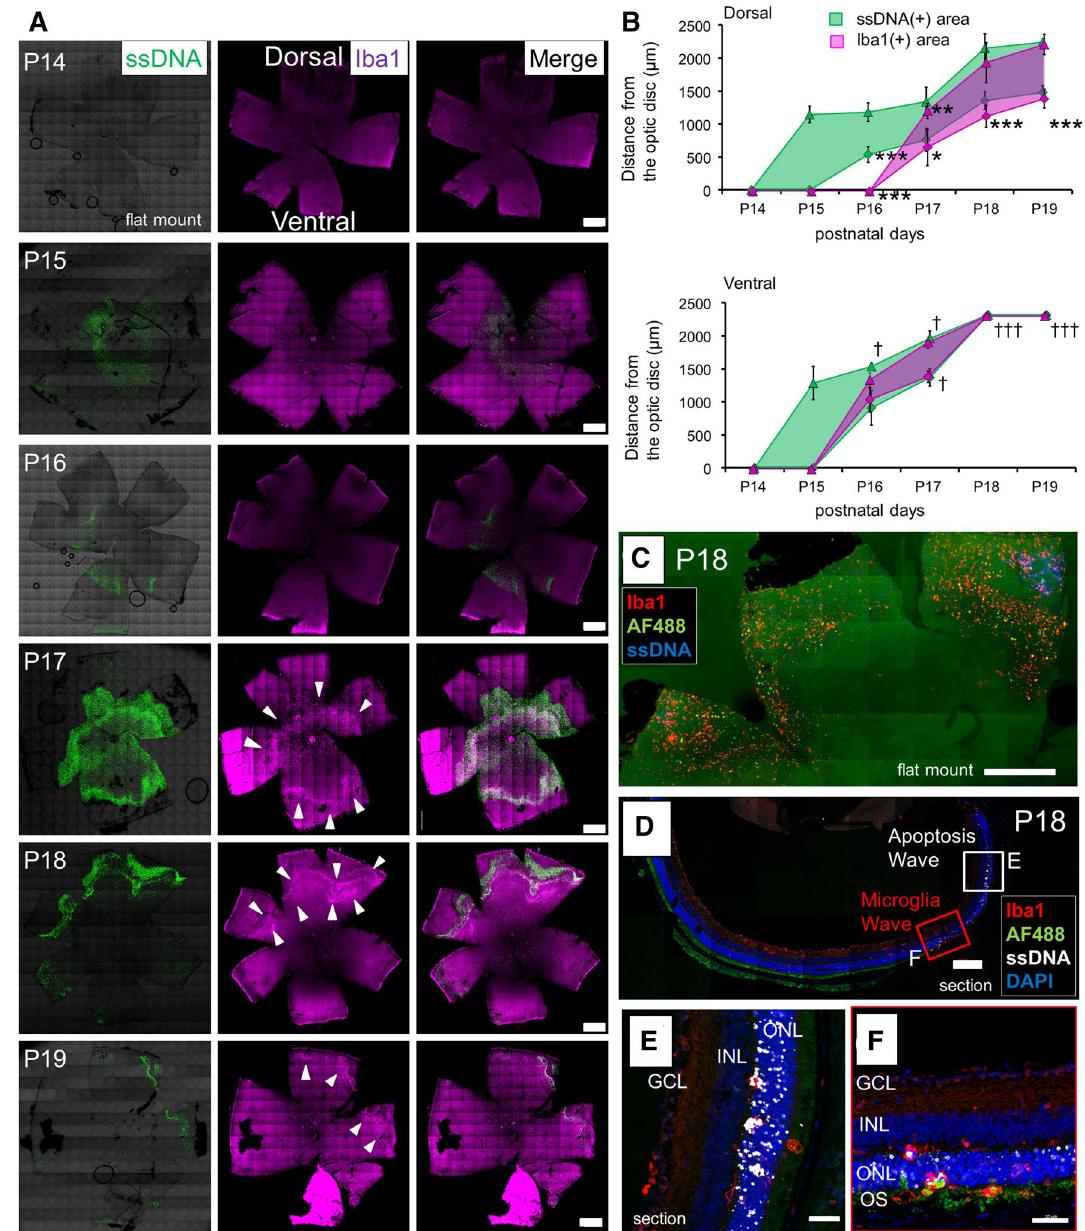
Figure 6. Spreading wave of photoreceptor apoptosis, and autofluorescent arc formed by microglia following the wave. ( A ) Retinal flat mounts in early phase of retinal degeneration in rd10 , labeled with ssDNA and Iba1. The wave of photoreceptor apoptosis spread over days, and the wave of Iba1 + microglia followed the apoptotic wave. Scale bars, 500 μm. ( B ) Graphs show the inner and outer diameter of ssDNA + apoptotic wave and Iba1 + microglia wave from the papillary center. The markers of the graph show mean and SD (n = 3, * p < 0.05, ** p < 0.005, *** p < 0.0005, t test of the Iba1 + wave in comparison to the ventral site. † p < 0.05, ††† p < 0.0005, t test of the ssDNA + wave in comparison to the dorsal site). ( C ) Immunohistochemistry of flat-mounted retina of rd10 (P18) showing positional relationship of apoptosis wave, microglia wave and autofluorescent spots. Some of Iba1 + microglia emitted autofluorescence. Scale bar, 500 μm. ( D – F ) Retinal section of rd10 (P18) labeled with Iba1 and ssDNA. ( D ) The retinal section revealed positional relationship of apoptotic wave, microglia wave and autofluorescent spots. Scale bar, 200 μm. ( E ) Magnified image of the retinal section with apoptotic wave. Apoptosis of the photoreceptors are profoundly accumulated in the ONL. Scale bar, 40 μm. ( F ) Magnified image of the retinal section with microglia wave. Infiltration of many microglia into the ONL was observed. Microglia that reached the OS emit autofluorescence. Scale bar, 40